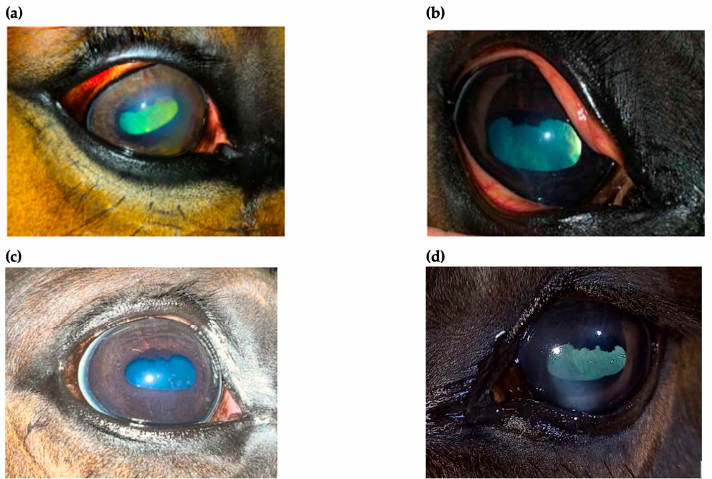
Figure 5. Superficial immune-mediated keratitis (IMMK) treated with TPU/PLDLA/CsA matrix im- plants 2 weeks post-injection ( a , d ) and mid-stromal IMMK with no corneal abnormalities detected after 6 weeks ( b ) and after 1 year ( c ).